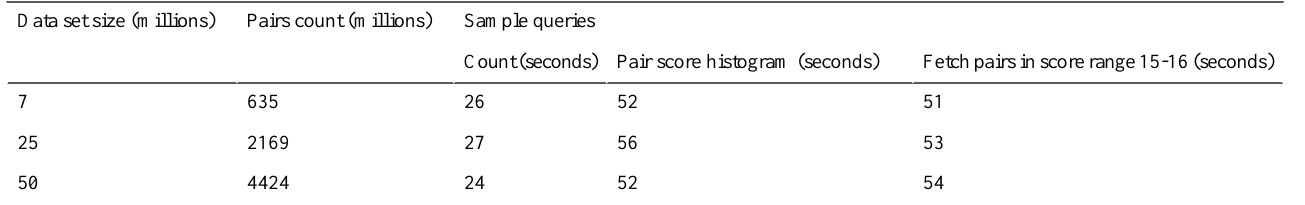
Table 4. Mean execution times for sample queries on full pairs set.